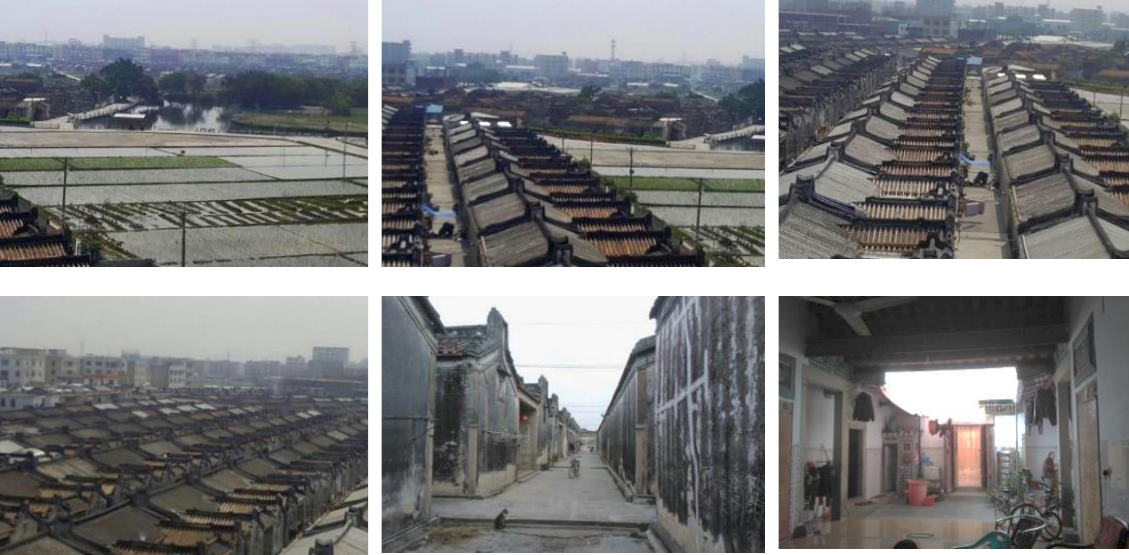
Figure. 11 The actual and interior photos of the application case (Chen,